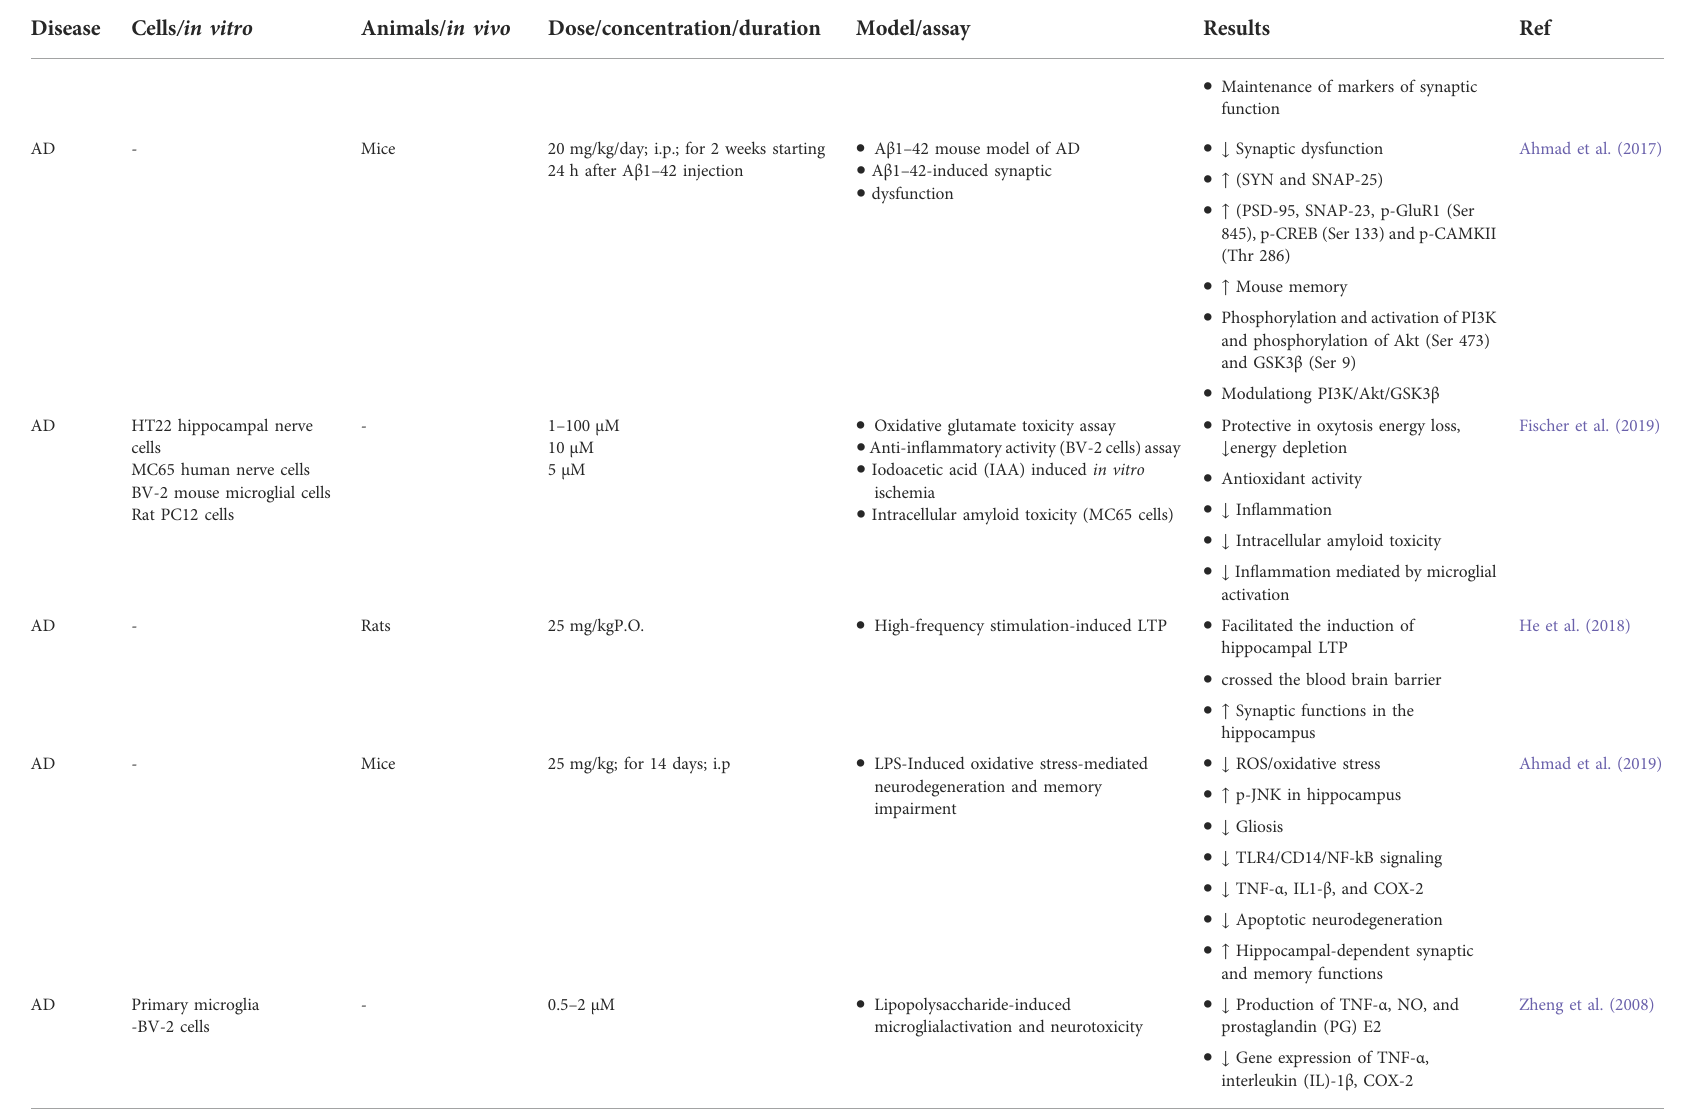
TABLE 1 ( Continued ) Different neurodegenerative disease and the protective role of fi